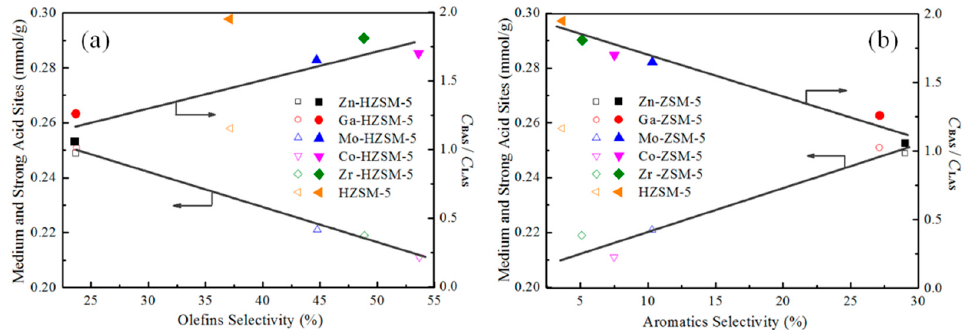
Figure 7. The impact of acidity on ( a ) olefins selectivity and ( b ) aromatics selectivity.